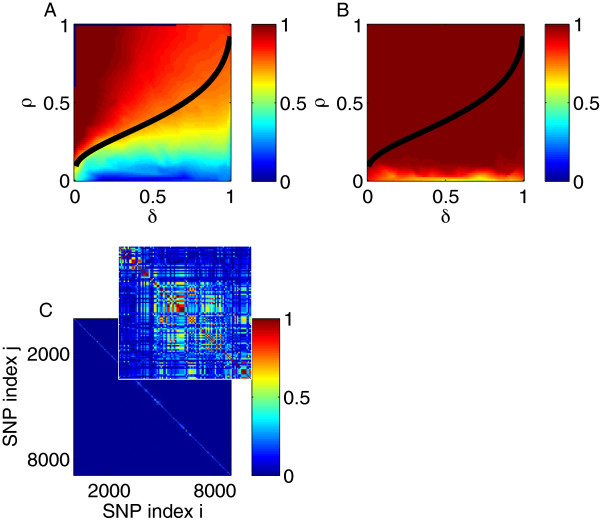
Analysis of chromosome 22. (A) The ρ − δ plane for h2 = 1. p was set to 8,915. Superimposed is the expected phase boundary when there is neither noise nor LD [26]. (B) The same as panel (A), except for h2 = 0.5. (C) The matrix of correlations (positive roots of the r2 LD measure) between genotyped SNPs on chromosome 22. Inset is a 100 × 100 sample along the diagonal.